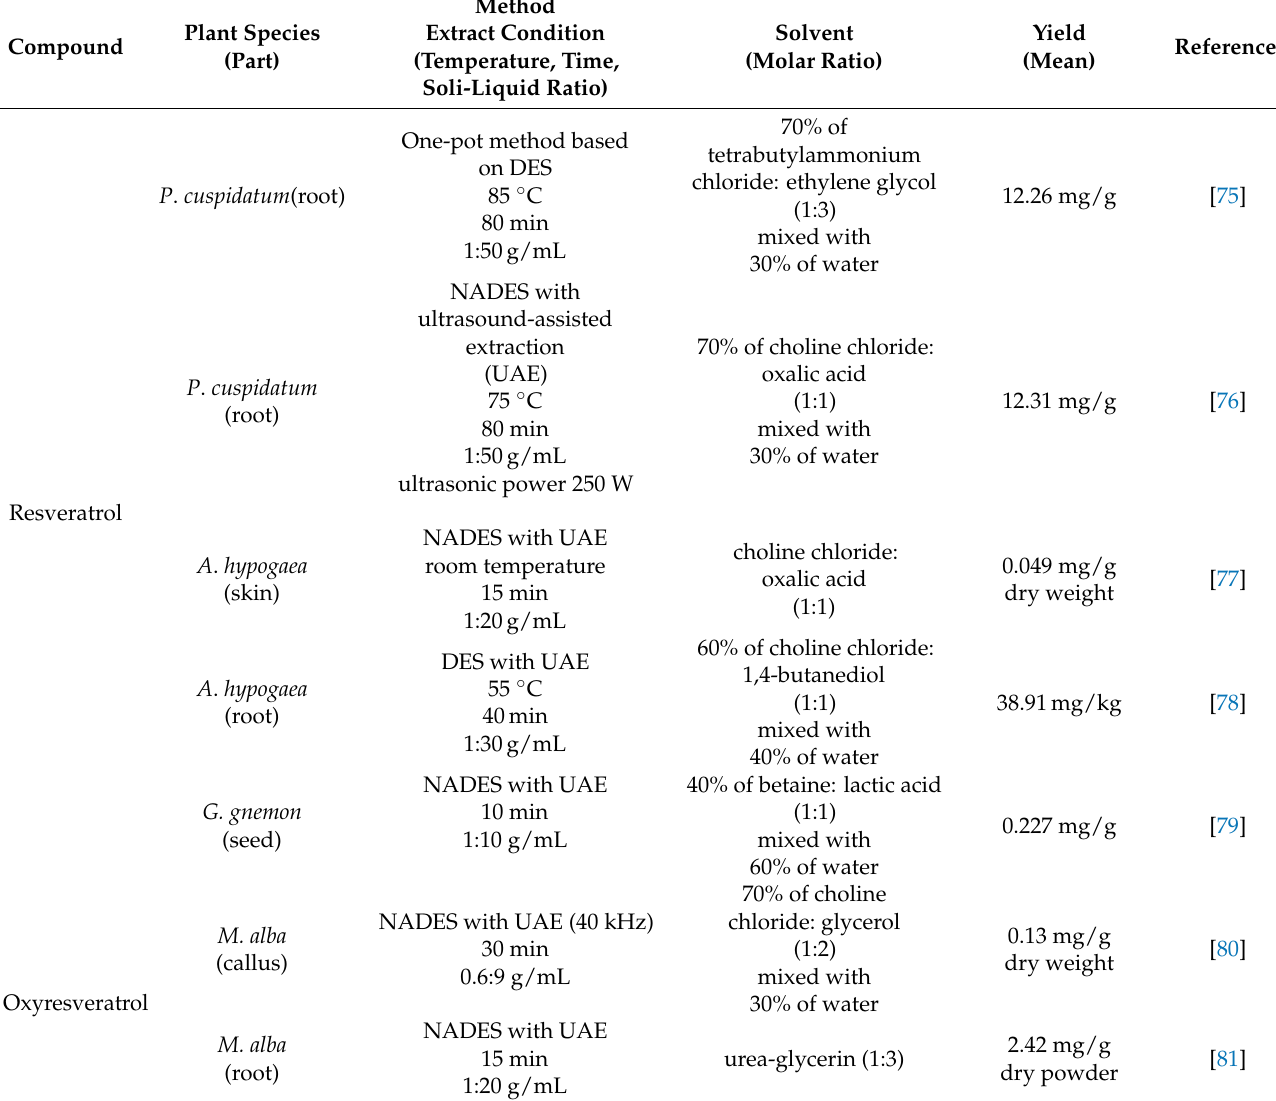
Table 3. Recent information of green solvent extraction for stilbenoids